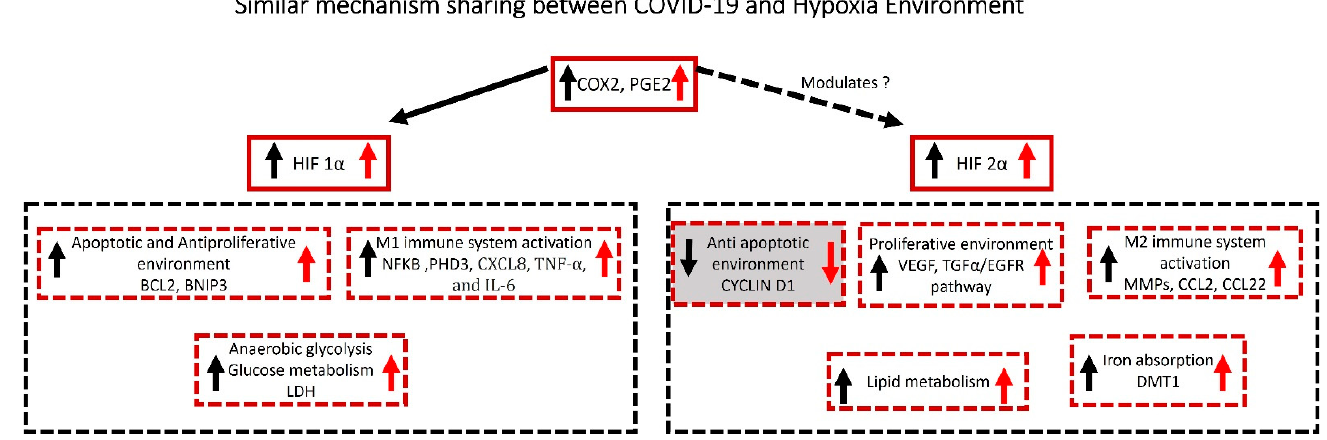
Figure 1. COX2/PGE2 pathway upregulates HIF-1 α which in turn increases antiapoptotic and antiproliferative environment (BCL2, BNIP3), increases M1 immune system activation (NFKB, PHD3, CXCL8, TNF- α and IL-6) and supports anaerobic glycolysis as indicated by increase in LDH levels. COX2/PGE2 pathway also modulates HIF-2 α that decreases antiapoptotic environment (CYCLIND1), increases proliferative environment (VEGF, TGF α , EGFR) and M2 immune system activation (MMPs, CCL2, CCL22), and supports increases in lipid metabolism and iron absorption (DMT1). Red arrows represent the expressions in people with COVID19 and black arrows represent the expression of molecules under hypoxia environment. COX2 is cyclooxygenase-2, PGE2 is prostaglandin E2, HIF-1 α is hypoxia-inducible factor 1-alpha, BCL2 is B-cell lymphoma 2, BNIP3 is BCL2/adenovirus E1B 19 kDa protein-interacting protein 3, NFKB is Nuclear factor kappa B, EGLN1 is egl-9 family hypoxia-inducible factor 1, CXCL8 is C-X-C motif chemokine ligand 8, TNF- α is tumor necrosis factor-alpha, IL-6 is interleukin-6, LDH is lactate dehydrogenase, HIF-2 α is hypoxia-inducible factor-2 alpha, (VEGF is vascular endothelial growth factor, TGF α is transforming growth factor alpha, EGFR is epidermal growth factor receptor, MMPs is matrix metalloproteinases, CCL2 and 22 are chemokine (C-C motif) ligand 2 and 22, DMT1 is divalent metal transporter